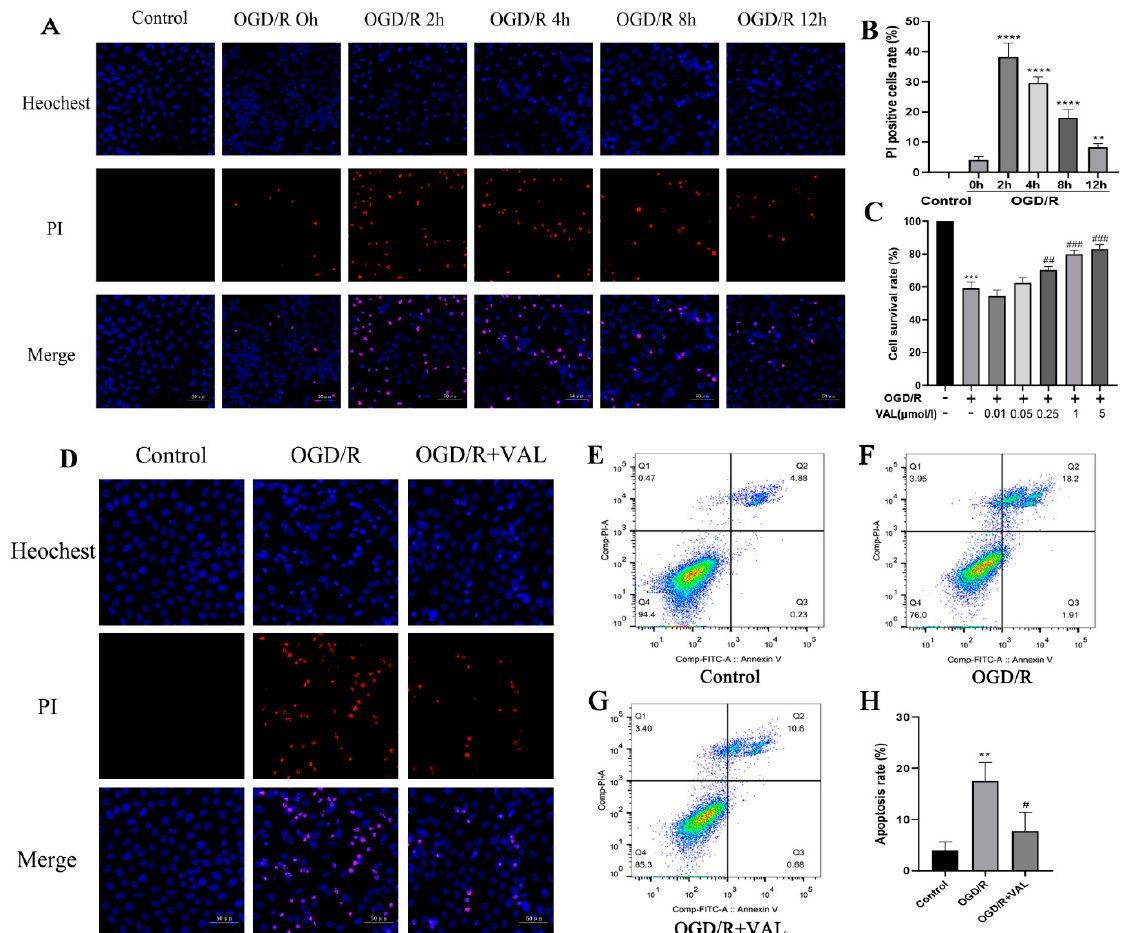
Figure 1. Valdecoxib reduces the number of PI-positive R28 cells and the cell apoptosis rate in the OGD/R model. R28 cells were pretreated with the indicated concentrations of valdecoxib for 4 h. ( A ) R28 cells in the control group and at multiple time points for the OGD/R model groups, stained with PI (red) and Hoechest (blue). Scale bar = 50 μ m. ( B ) Proportion of PI-positive R28 cells in the control group and OGD/R 0 h, 2 h, 4 h, 8 h and 12 h groups. ( C ) CCK-8 was used to detect R28 cells’ survival rates in the control group, OGD/R group and OGD/R groups pretreated with valdecoxib of different concentrations. The data show a significant increase in the cell survival rate observed at the concen- trations of 1 and 5 μ m VAL compared to the OGD/R group. ( D ) R28 cells in the control, OGD/R and OGD/R+VAL groups, stained with PI (red) and Hoechest (blue). Scale bar = 50 μ m. ( E – H ) Valdecoxib reduced the cell apoptosis rate in the OGD/R model as measured by annexin V-FITC/PI staining and flow cytometry analysis. Q3: early apoptosis, Q2: late apoptosis. The untreated control group is as- signed a survival rate of 100%. Data are presented as the mean ± SD of three independent experi- ments. **** p < 0.0001, ** p < 0.01 vs. control group in Figure 1B. *** p < 0.001 vs. control group, ## p < 0.01, ### p < 0.001 vs. OGD/R group in Figure 1C. ** p < 0.01 vs. control group, # p < 0.05 vs. OGD/R group in Figure 1H.